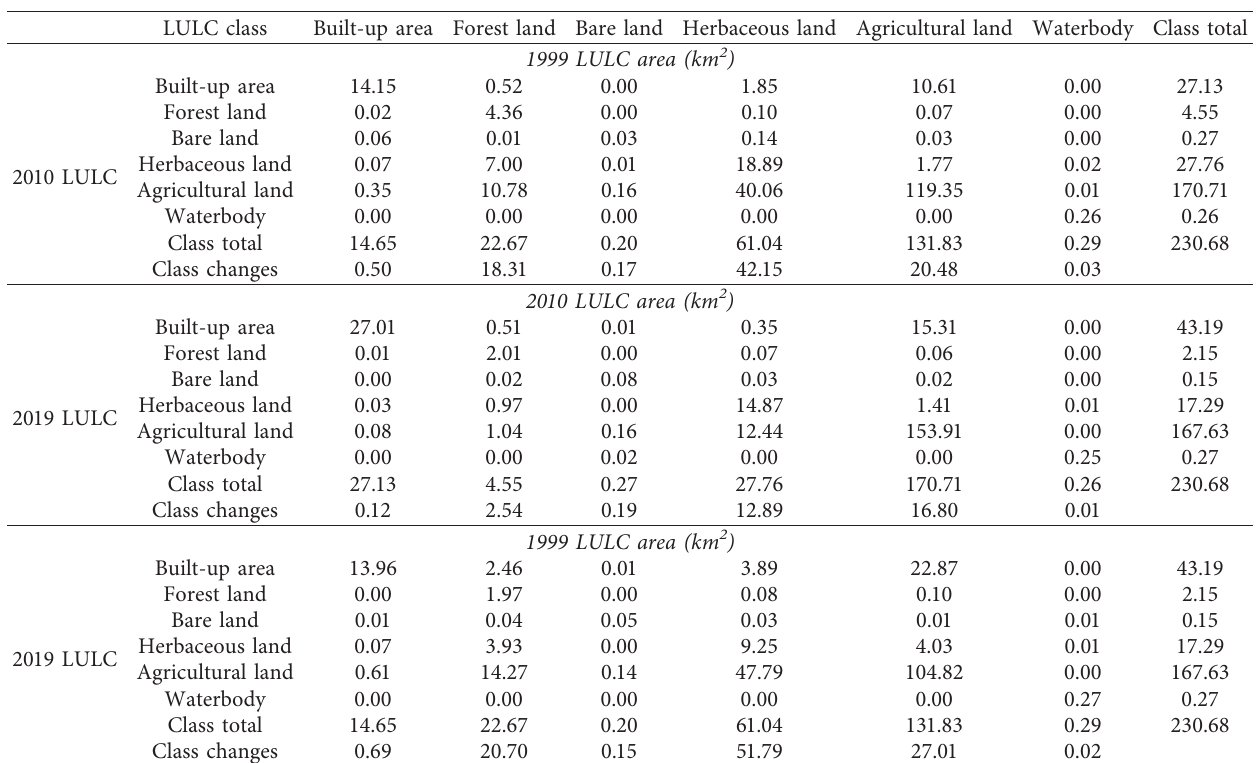
Table 5: LULC class change/transition matrix.